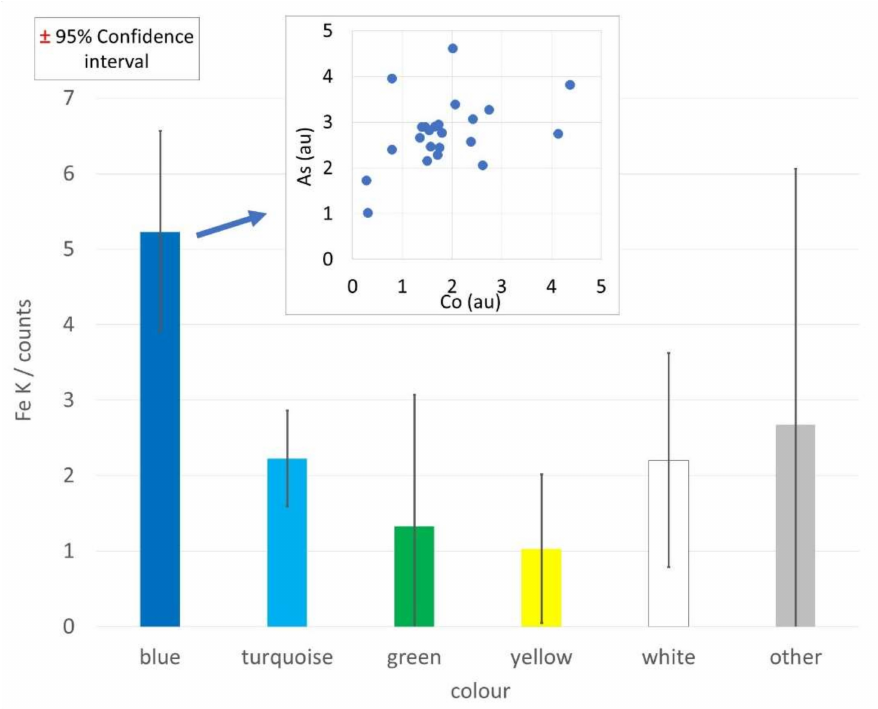
Figure 8. XRF counts of iron for blue, compared to the other glaze colours obtained. Scatter plot of Co against, as in blue glazes (insert), both in arbitrary